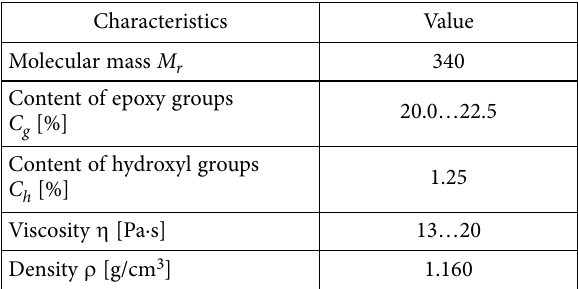
Table 2. Characteristics of epoxy oligomer ED-20 Characteristics